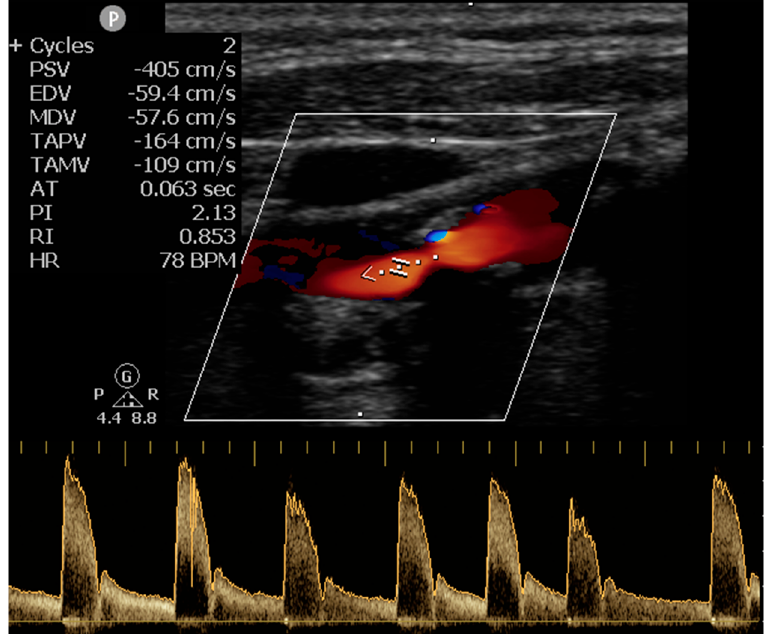
Figure 1. Detection of cardiac arrhythmia during spectral waveform analysis of external carotid artery in cervical duplex ultrasound.